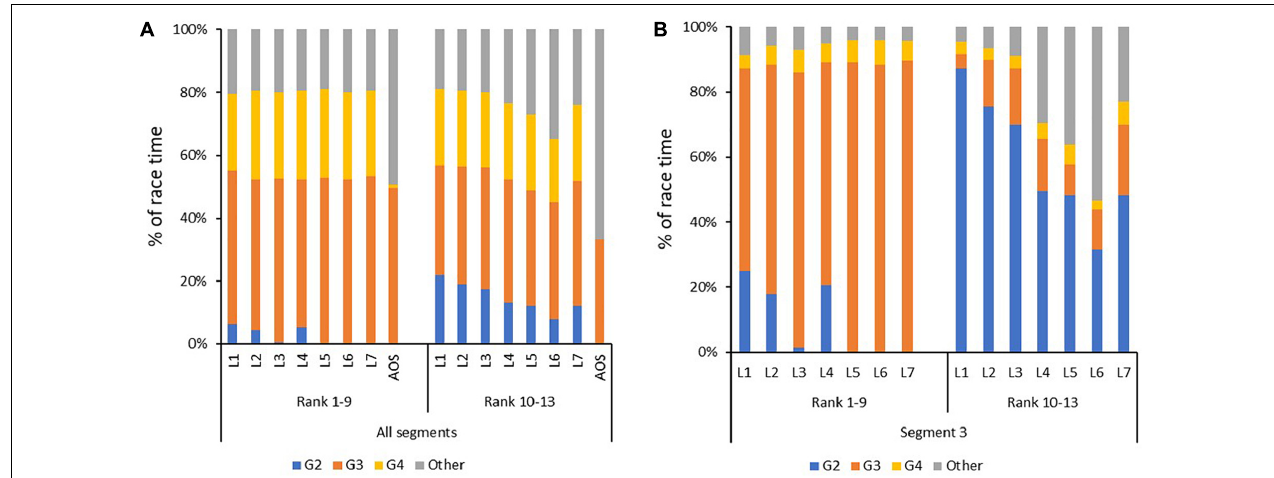
FIGURE 3 | Distribution of sub-techniques [in % of time] for each of the seven 3-min laps (L) during the simulated mass-start, with the skiers divided into two groups: (A) for all four segments in the initial 21-min and the all-out sprint (AOS; see Figure 1 for the protocol) and (B) for the steepest uphill. Skiers ranked 1–9 are those who were able to finish the entire protocol without requiring breaks and rank 10–13 consists of the 4 lowest ranked skiers that required one or more breaks to complete